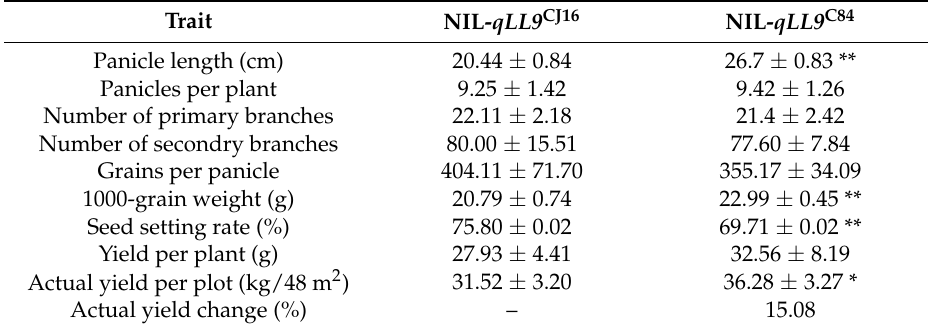
Figure 10. Panicle and grain morphology of NIL- qLL9 CJ16 and NIL- qLL9 C84 . ( a , b ) Panicle morphology at heading stage; bars = 4 cm. ( c , d ) Grain morphology at repining stage; bar = 1 cm. ( e ) Grain length. ( f ) Grain width and thickness. Data are represented as mean ± SD ( n = 10). Asterisks represent significant difference determined by Student’s t -test at p -value <0.01 (**), p -value <0.05 (*). Table 7. Yield traits of NIL- qLL9 CJ16 and NIL- qLL9 C84 .